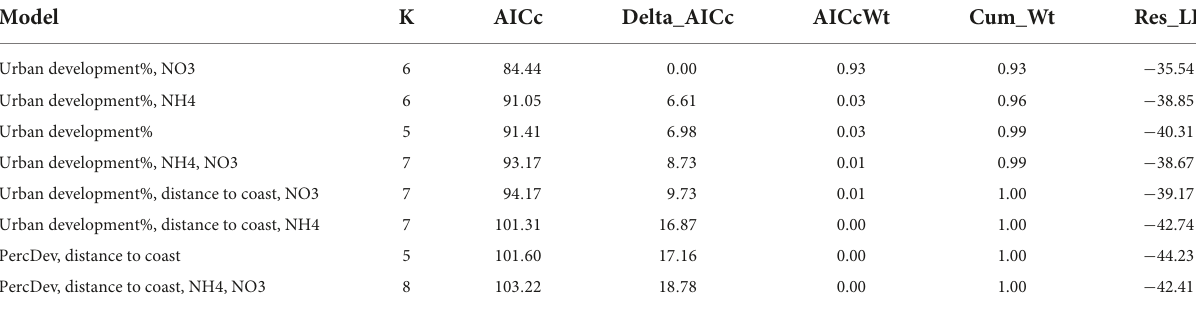
TABLE 1 Model selection for what abiotic factors best fit alpha diversity. Model